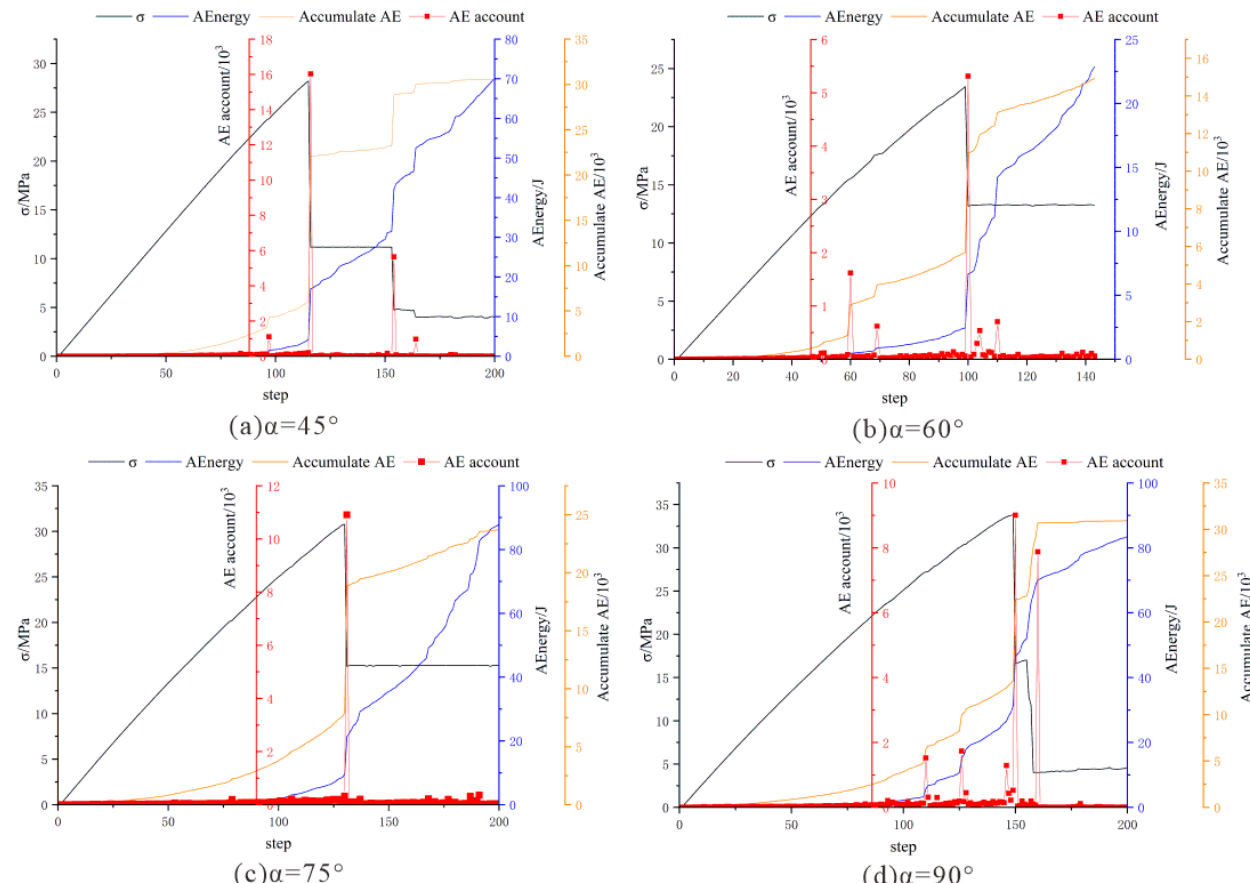
Figure 12. Relationship between loading stress, AE account, Accumulative AE and AEnergy and step number of coal under high dip angle.